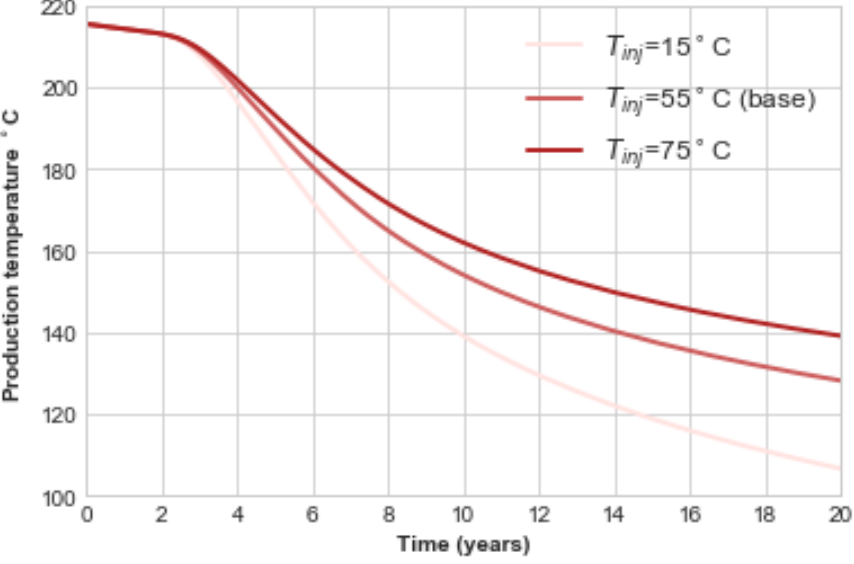
Figure 12. Production temperature decline curve over 20 years of simulation for different injection temperatures